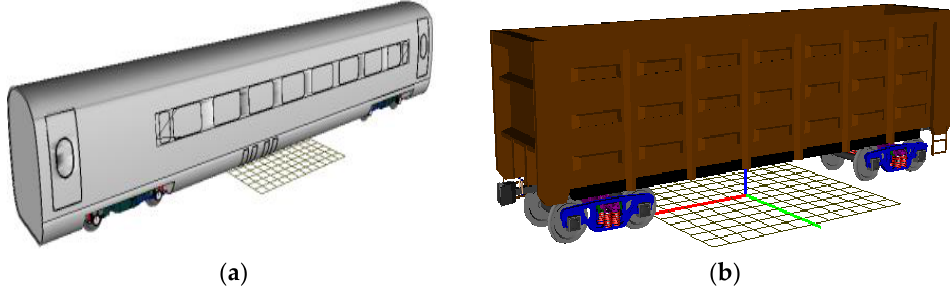
Figure 10. Train model: ( a ) Passenger train model. ( b ) Freight train model.